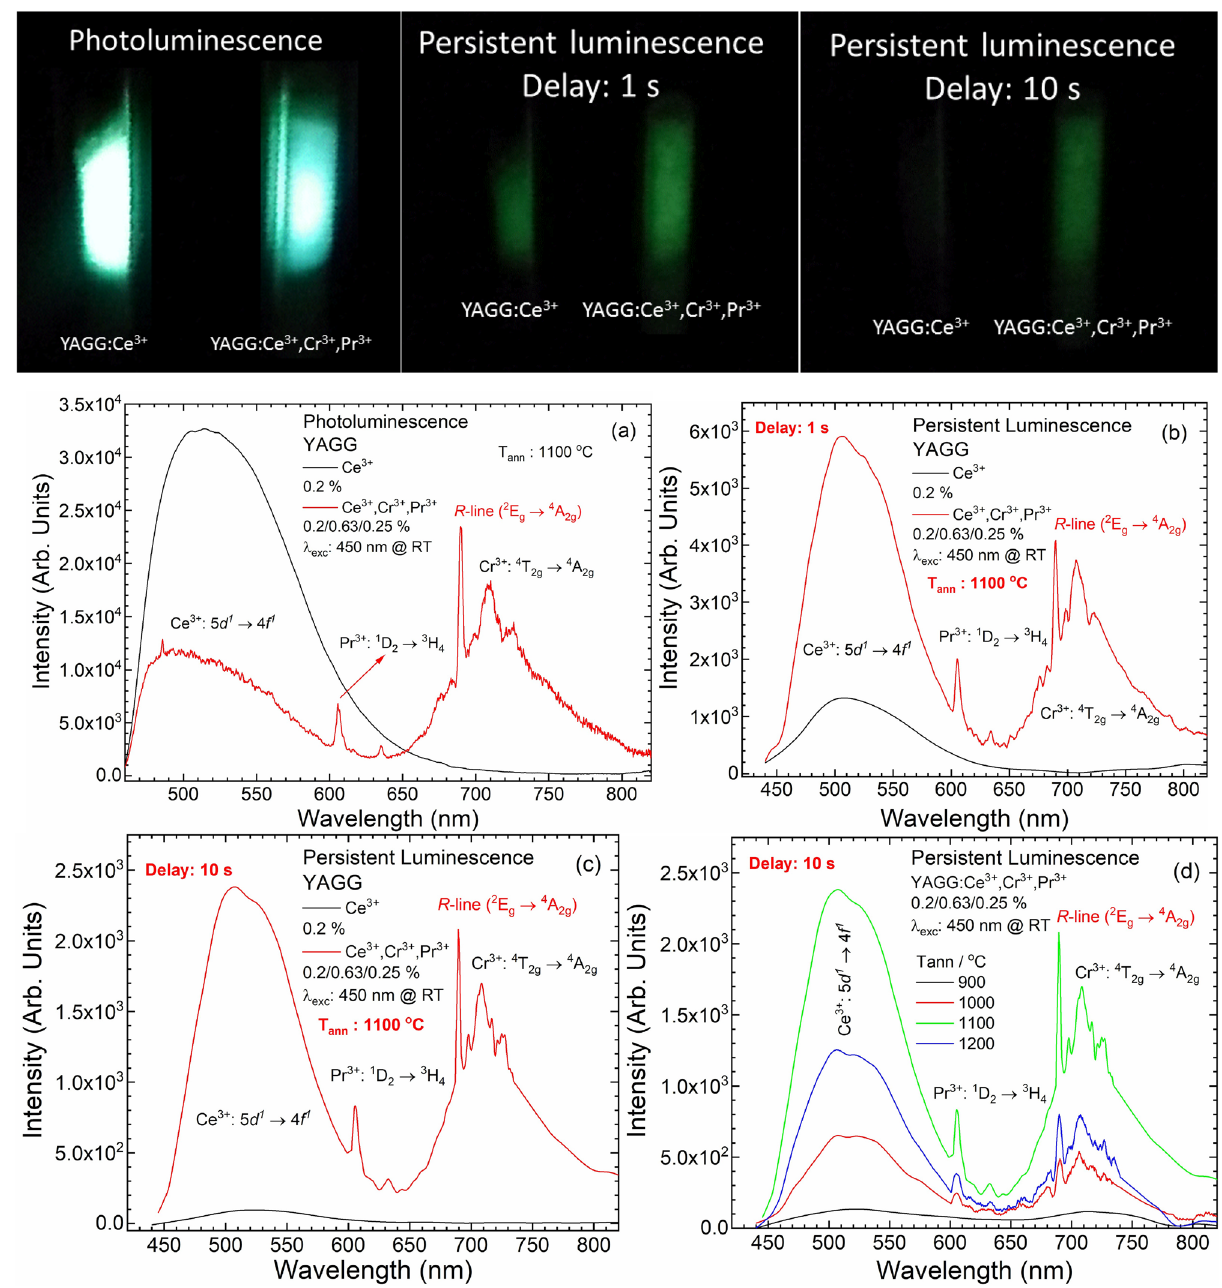
Figure 7. Photos of PL and PersL, as well as PL ( a ) and PersL spectra of YAGG:Ce 3+ and YAGG:Ce 3+ ,Cr 3+ ,Pr 3+ nanophosphors annealed at 1100 °C after 1 s ( b ) and 10 s of delay ( c ) and PersL spectra as a function of particle size ( d